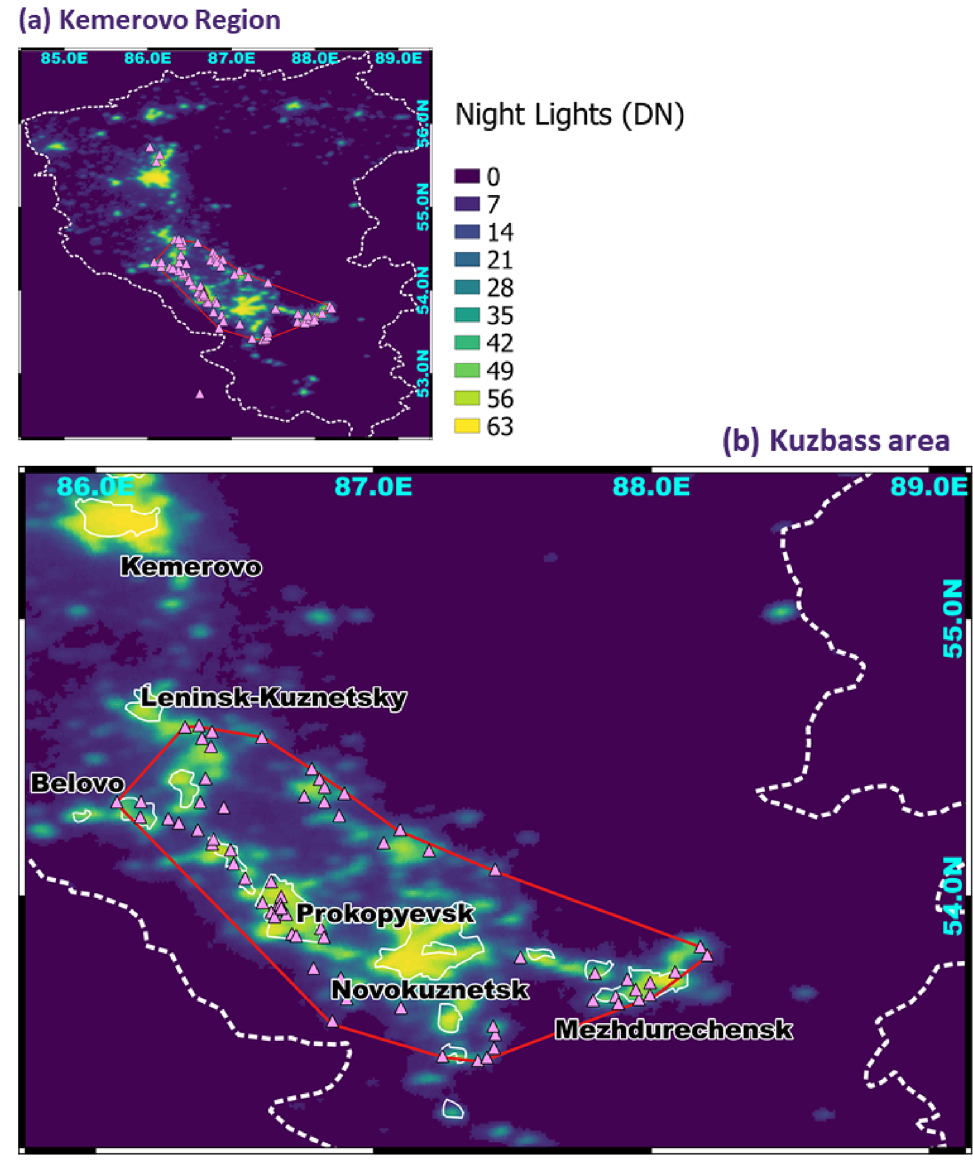
Figure 2. The delineated cluster of coal quarries and large cities, representing Kuzbass, shown on ( a ) the Kemerovo administrative region map (dashed white line) with Kuzbass coal basin (red polygon) and on ( b ) the zoomed-in map of the Kuzbass coal basin (red polygon) with the detected open coal quarries (triangles), MODIS urban pixels (white solid line) and night-lights (black-yellow